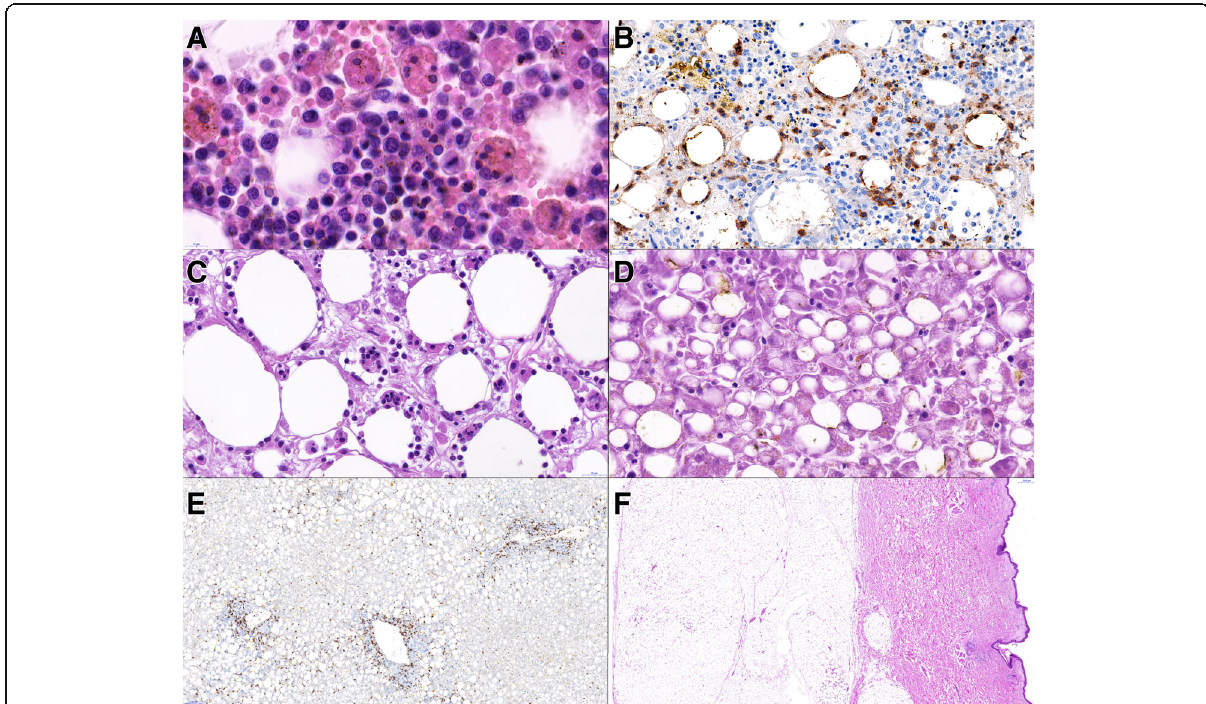
Fig. 4 scans of histological slides from the autopsy. A – vertebral bone marrow with large macrophages engulfing red cells and lymphocytes (hemophagocytosis). HE, 130x. B – vertebral bone marrow with focal finding of CD8+ lymphocytes rimming the adipocytes; the finding is highly suspect from infiltration by lymphoma, CD8 immunohistochemistry, 55x. C – mesentery with macrophages engulfing lymphocytes, HE, 73x. D – liver tissue showing marked dystrophic changes including steatosis and cholestasis of hepatocytes. HE, 70x. E – liver tissue without apparent lymphoma infiltration. CD3 immunohistochemistry, 12x. F – sample from skin and subcutis tissue without apparent lymphoma infiltration. HE,